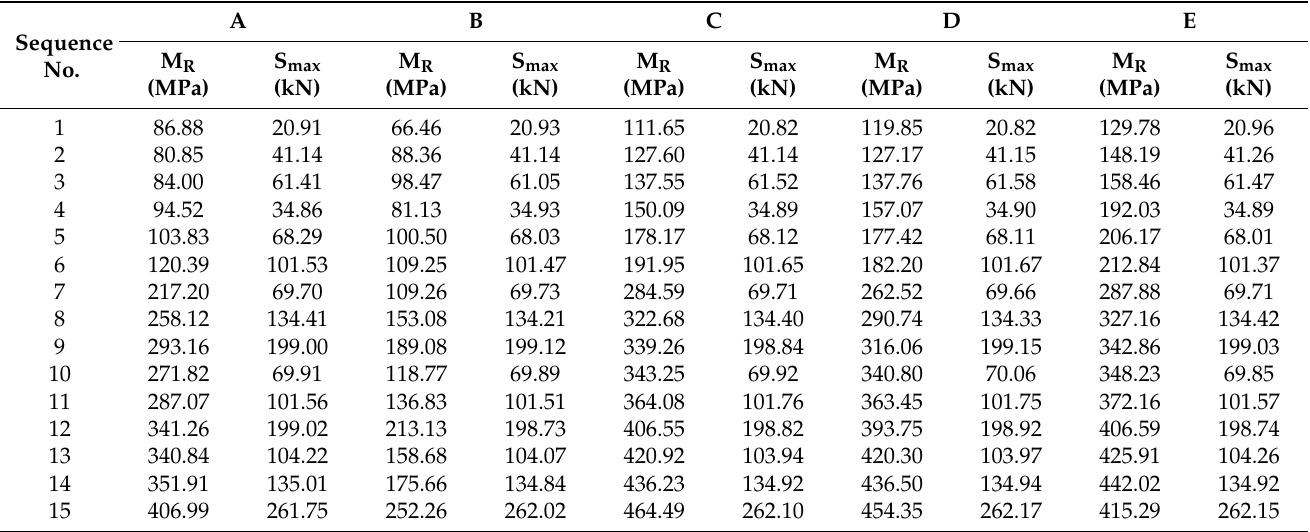
Table 4. Results of the TRL tests regarding the M R calculation for all blends.